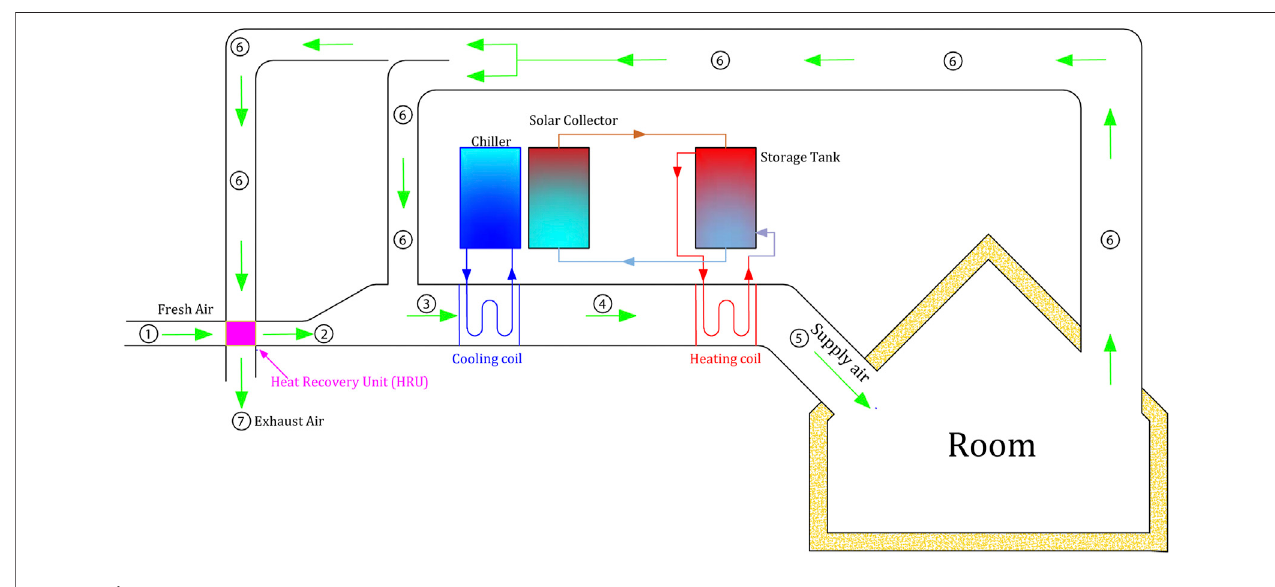
FIGURE 1 | Solar-assisted AHU.